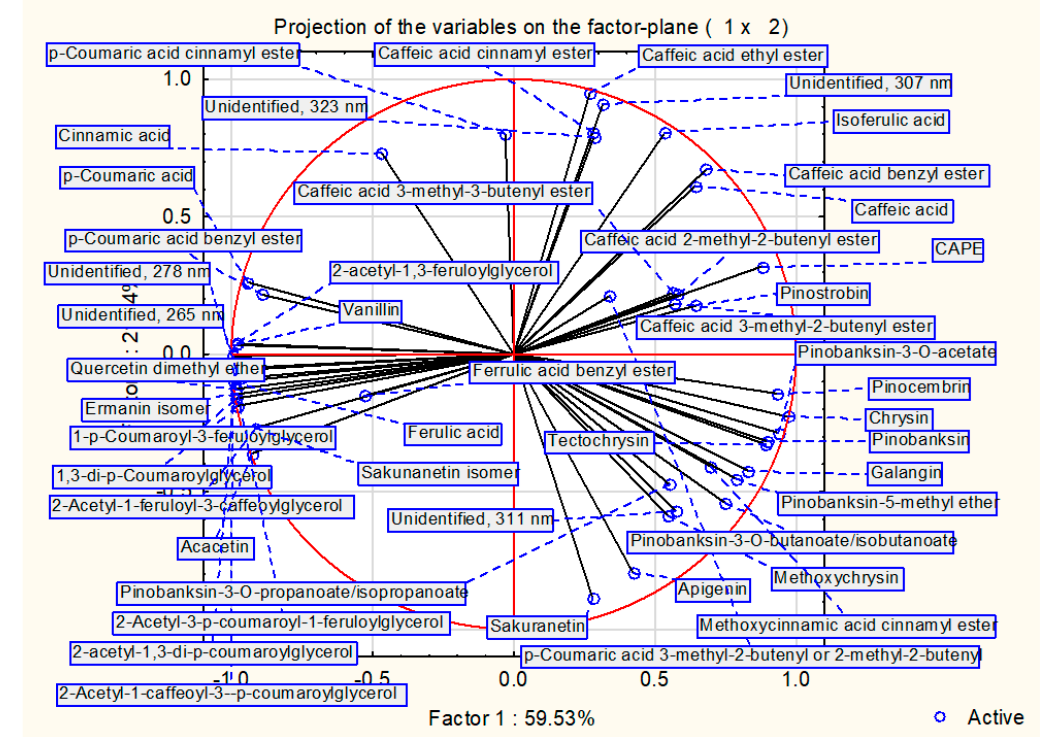
Figure 3. Projection of variables on the factor plane.